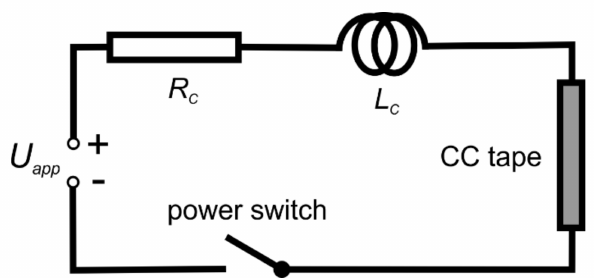
Figure 3. Schematic drawing of the circuit used in current limitation experiments. Set of accumulator battery cells serves as the power supply with voltage U app . R c and L c represent the circuit resistance and inductance, respectively. The signal wires allowing measuring the voltages on di ff erent portions of the circuit are not